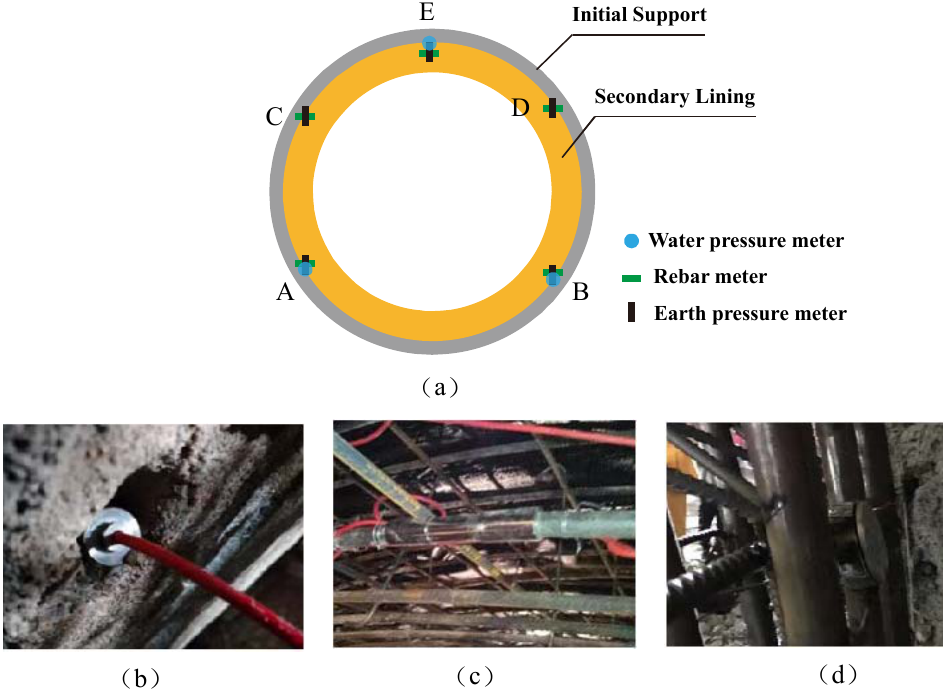
Figure 21. Diagram of the layout of the monitoring section measurement points and the installation of instruments on site: ( a ) monitoring section measurement point layout diagram; ( b ) on-site water pressure meter installation diagram; ( c ) on-site rebar meter installation diagram; ( d ) on-site earth pressure meter installation diagram.